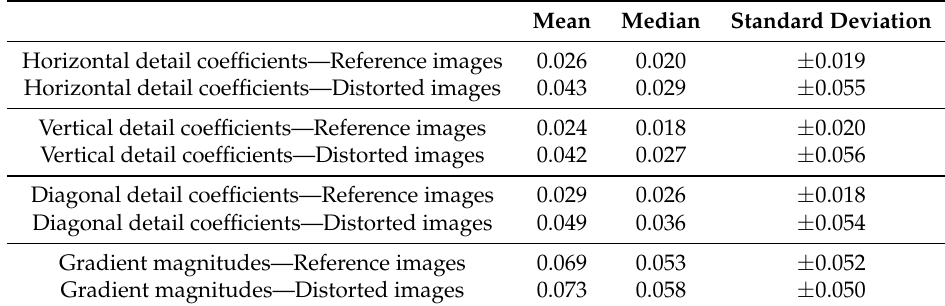
Table 1. Mean and median distances from the Benford’s law in TID2013 [39] measured in the wavelet (horizontal, vertical, and diagonal detail coefficients) and spatial (gradient magnitude)